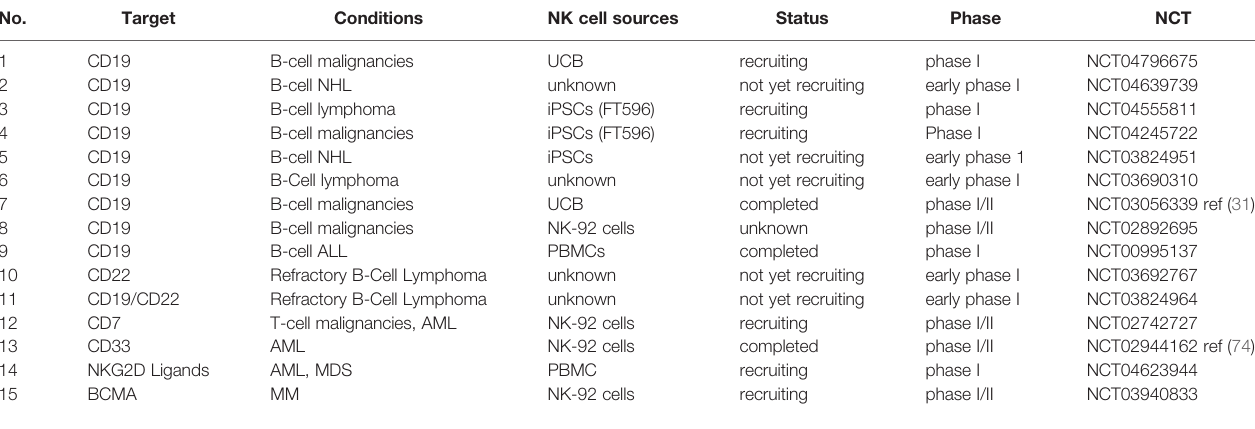
TABLE 1 | Clinical trials of CAR-NK cells in hematological malignancies.